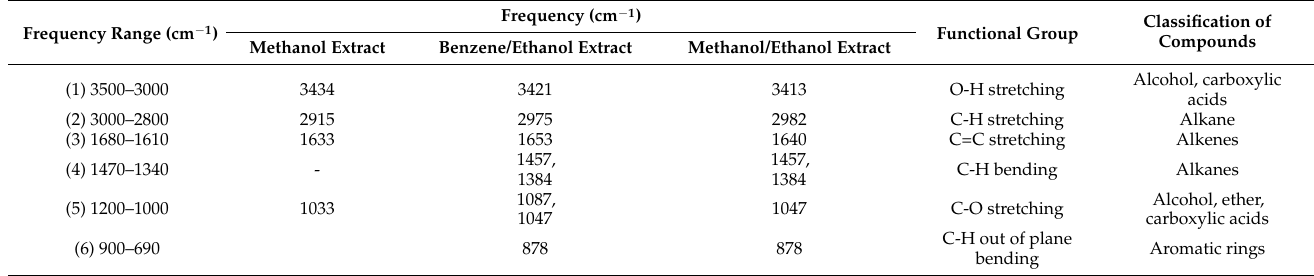
Table 1. The functional group and classification of compounds obtained of RPB